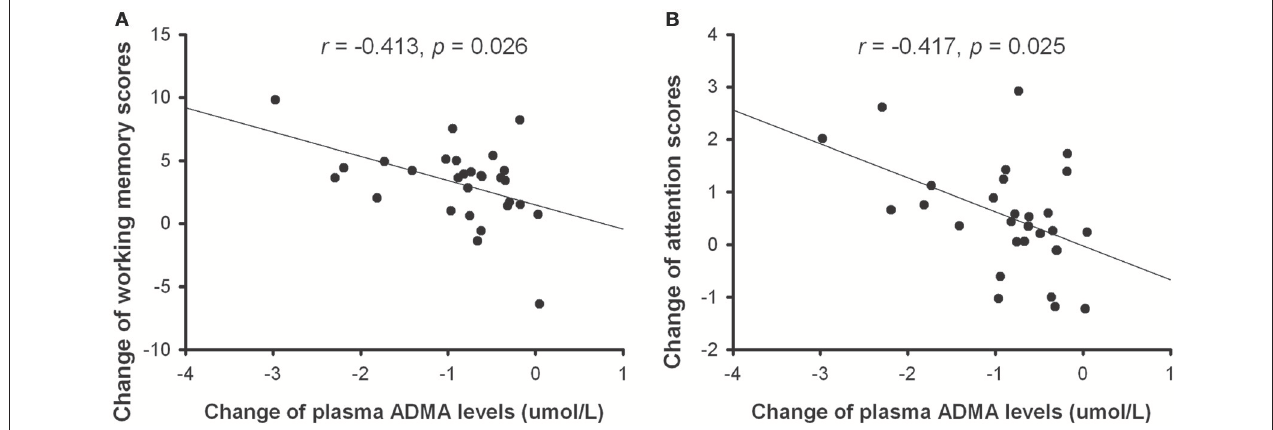
FIGURE 2 | The correlation between the change of plasma ADMA levels and improvement of working memory (A) or attention (B) in patients with atypical antipsychotic